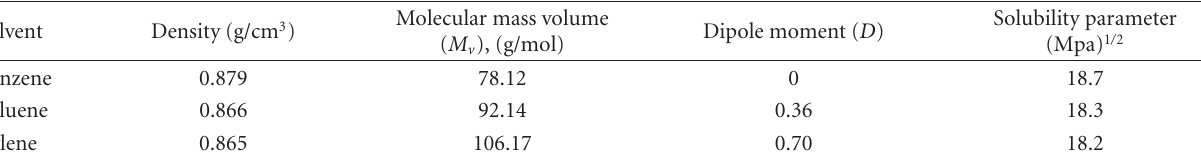
Table 1: Properties of solvents.